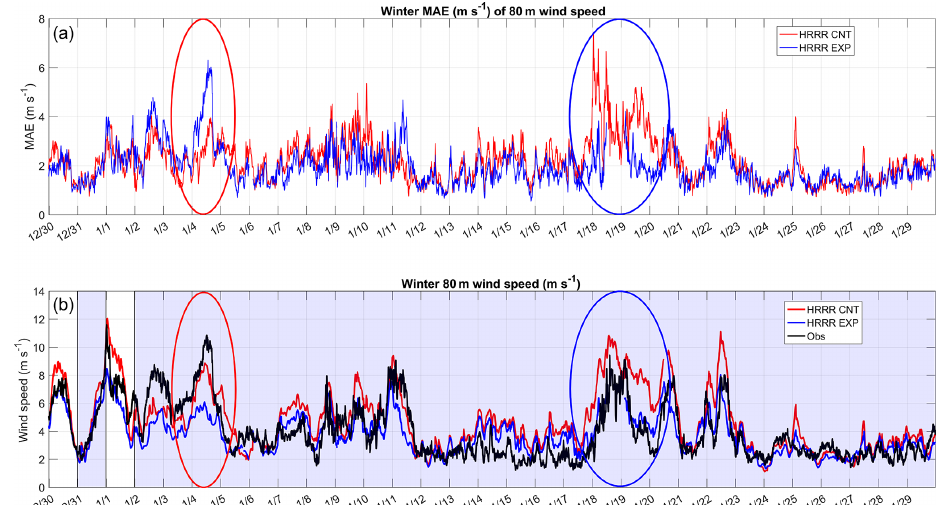
Figure 13. As in Fig. 12, but for part of the winter 2017 reforecast period.